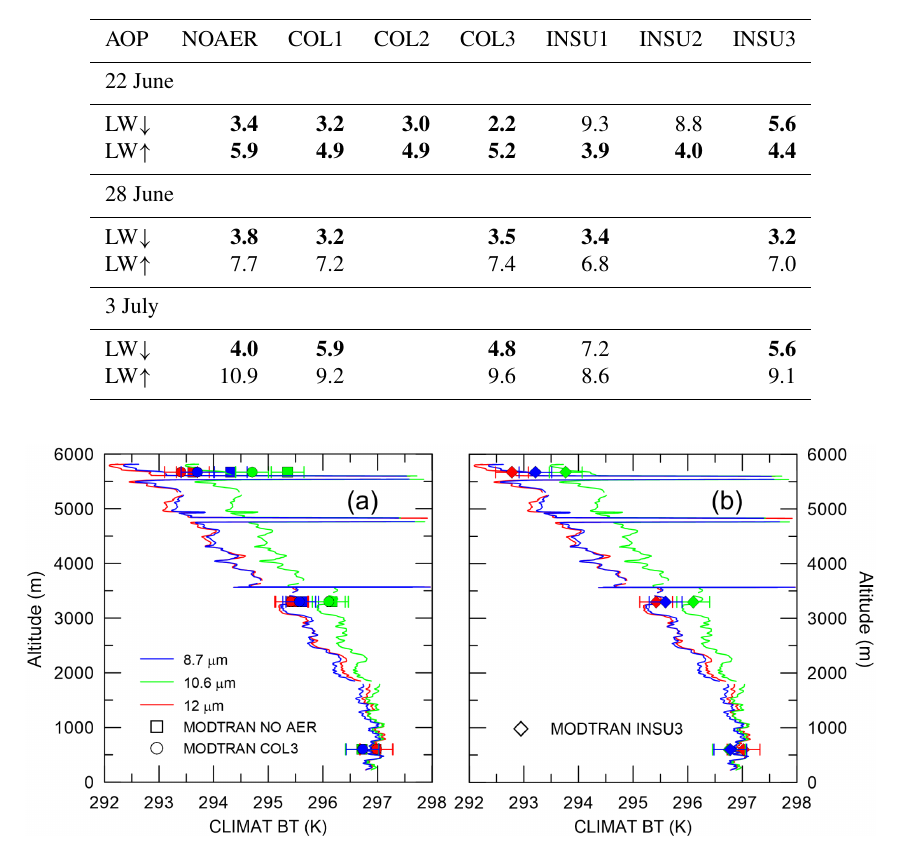
Figure 7. CLIMAT BTs vertical profiles and simulated BTs at selected altitudes during F35 for aerosol-free conditions and with different AOPs: Algerian and Moroccan dust RIs with (a) AERONET, and (b) in situ